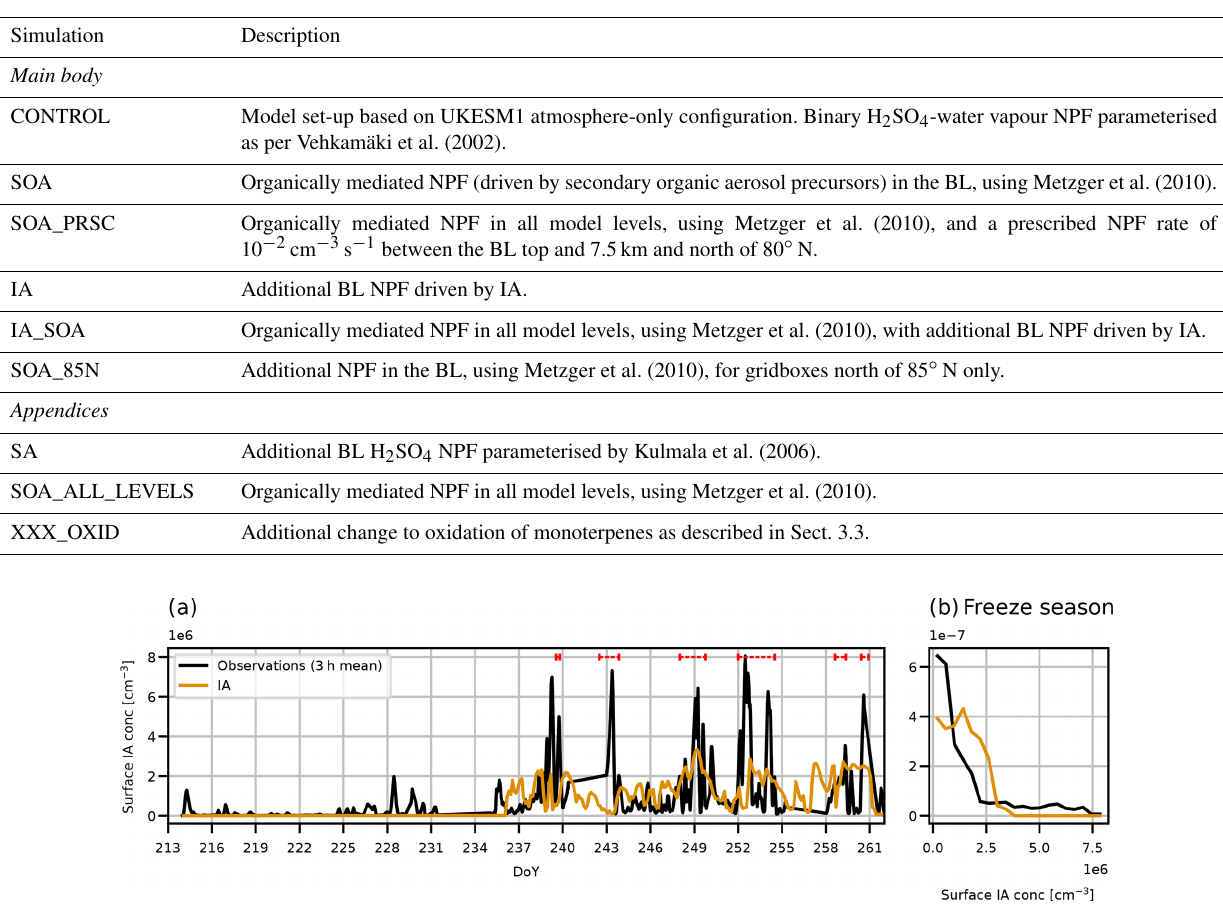
Figure 2. Times series and PDF of surface iodic acid concentration during AO2018 from observations and model output. Model output is from simulation IA (orange lines). Observations are shown as 3-hourly mean (black lines). Red dashed lines in (a) show periods of observed NPF events. PDF of concentration is for freeze season only, i.e. after 27 August 2018 (day 239).